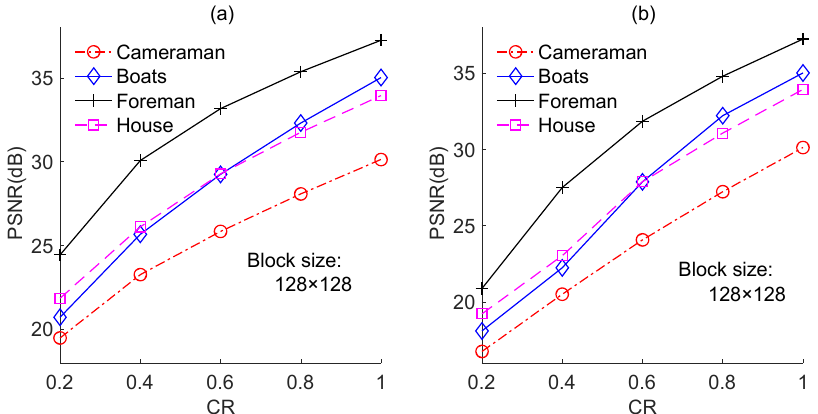
Figure 14. PSNRs of the proposed image-based BCS on different test images. ( a ) is based on Zadoff– Chu measurement matrix; ( b ) is based on real-valued Hadamard measurement matrix.